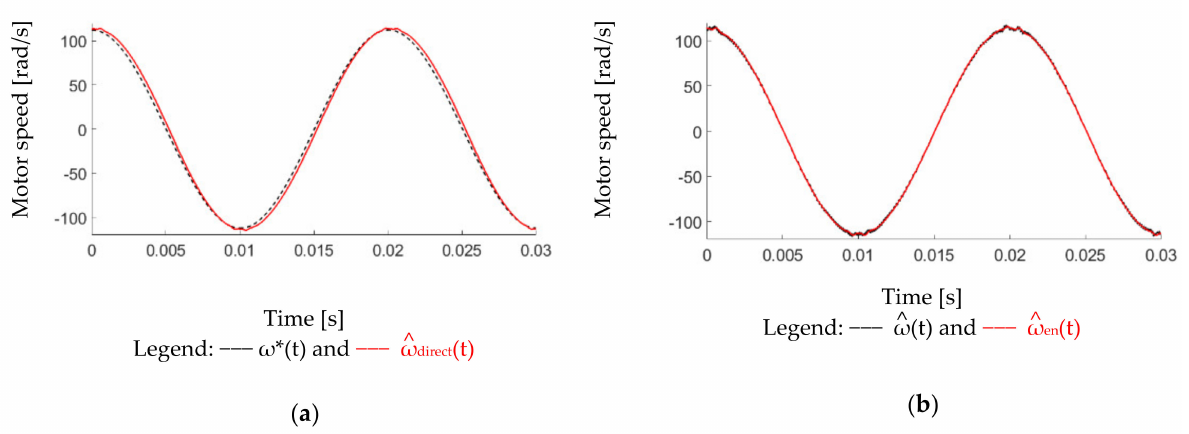
Figure 18. Comparison of different speed estimations under a 50 Hz speed command with 0.64 g · cm 2 mirror load: ( a ) ω * and ˆ ω direct and ( b ) ˆ ω and ˆ ω en (2.5 kHz speed observer